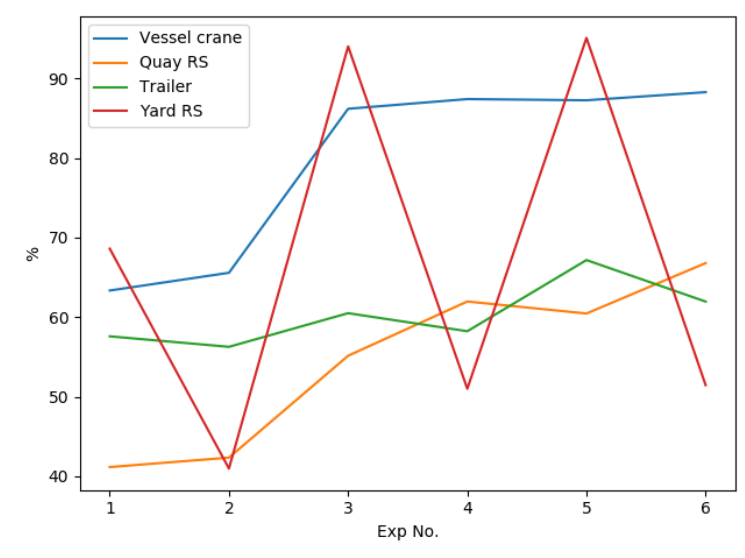
Figure 12. Comparison of the utilization under different combinations of equipment. Table 2. Experiment specifications of combinations of equipment. Experiment